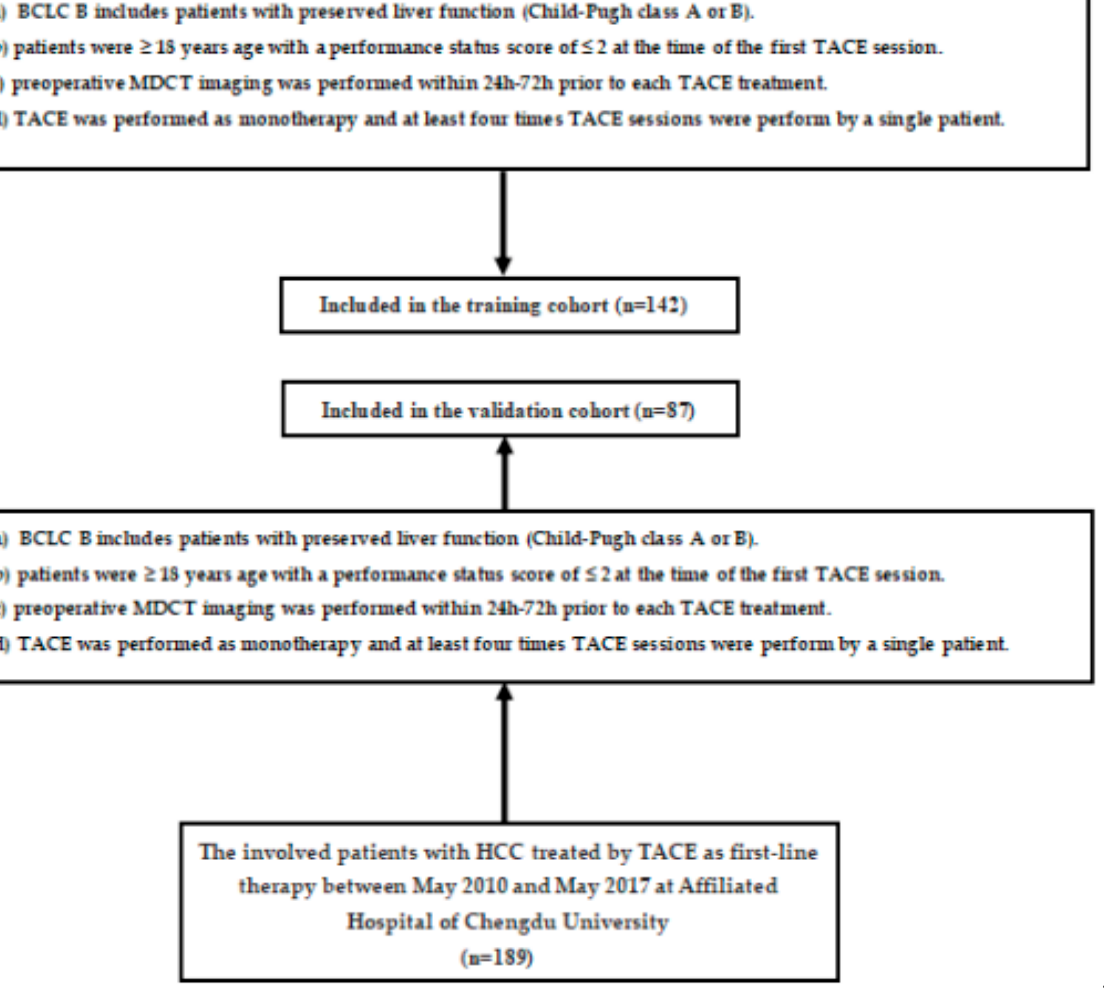
Figure 1. Flowchart for inclusion and exclusion of patients within the training and validation cohorts. TACE: transarterial chemoembolization; BCLC: Barcelona Clinic Liver Cancer; MDCT: multi-detector computed tomography; HCC: hepatocellular carcinoma.